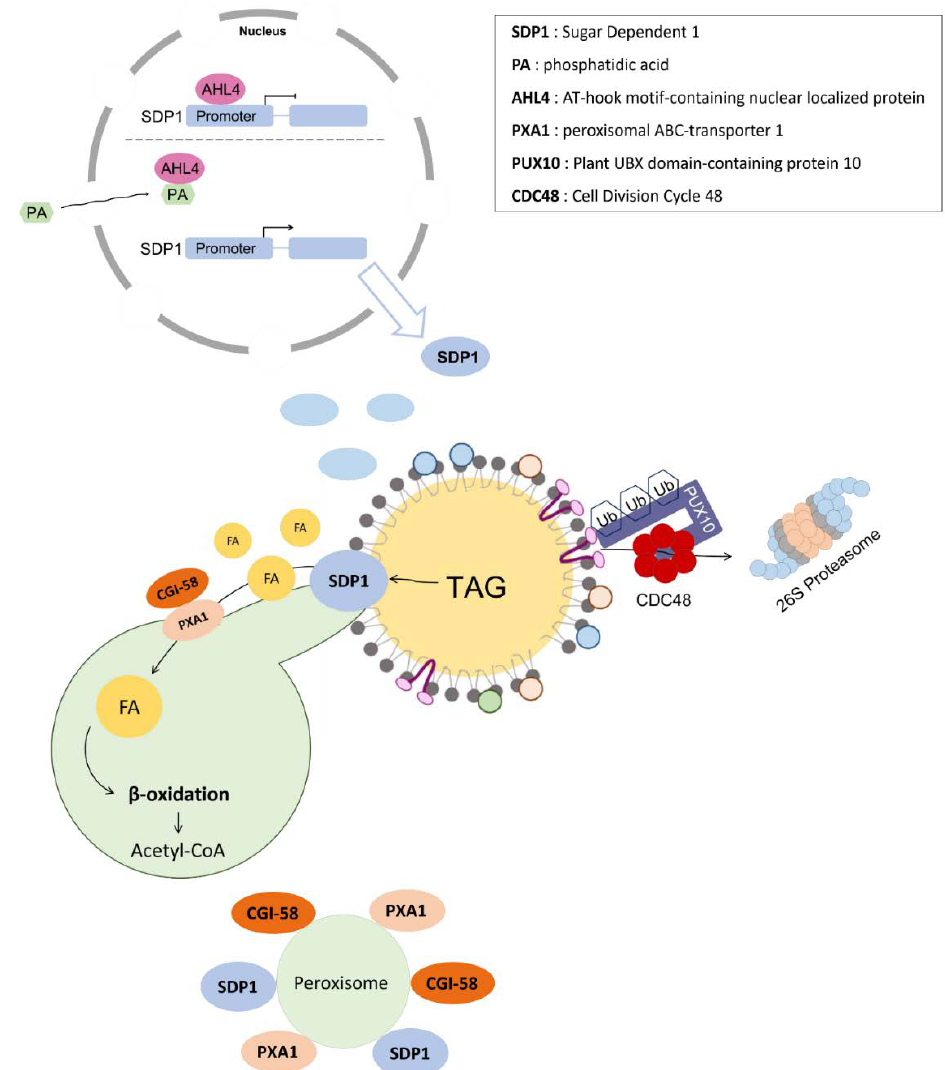
Figure 2. Mobilization of lipid droplets by plant lipases. AHL4, AT-hook motif-containing nuclear localized protein 4; SDP1, sugar-dependent 1; PA, phosphatidic acid; CGI-58, comparative gene identification-58; PXA1, peroxisomal membrane ATP-binding cassette (ABC) transporter 1; PUX10, plant UBX-domain containing protein 10; CDC48, cell division cycle 48.